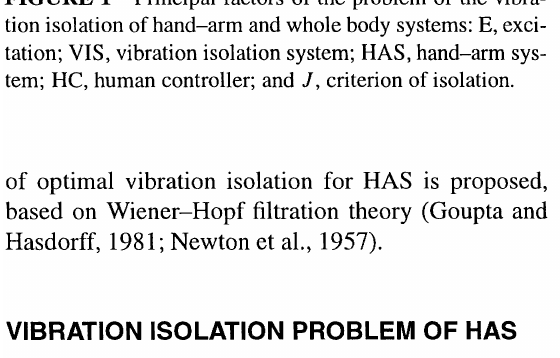
FIGURE 3 Dynamical structure of the 3-DOF hand-arm